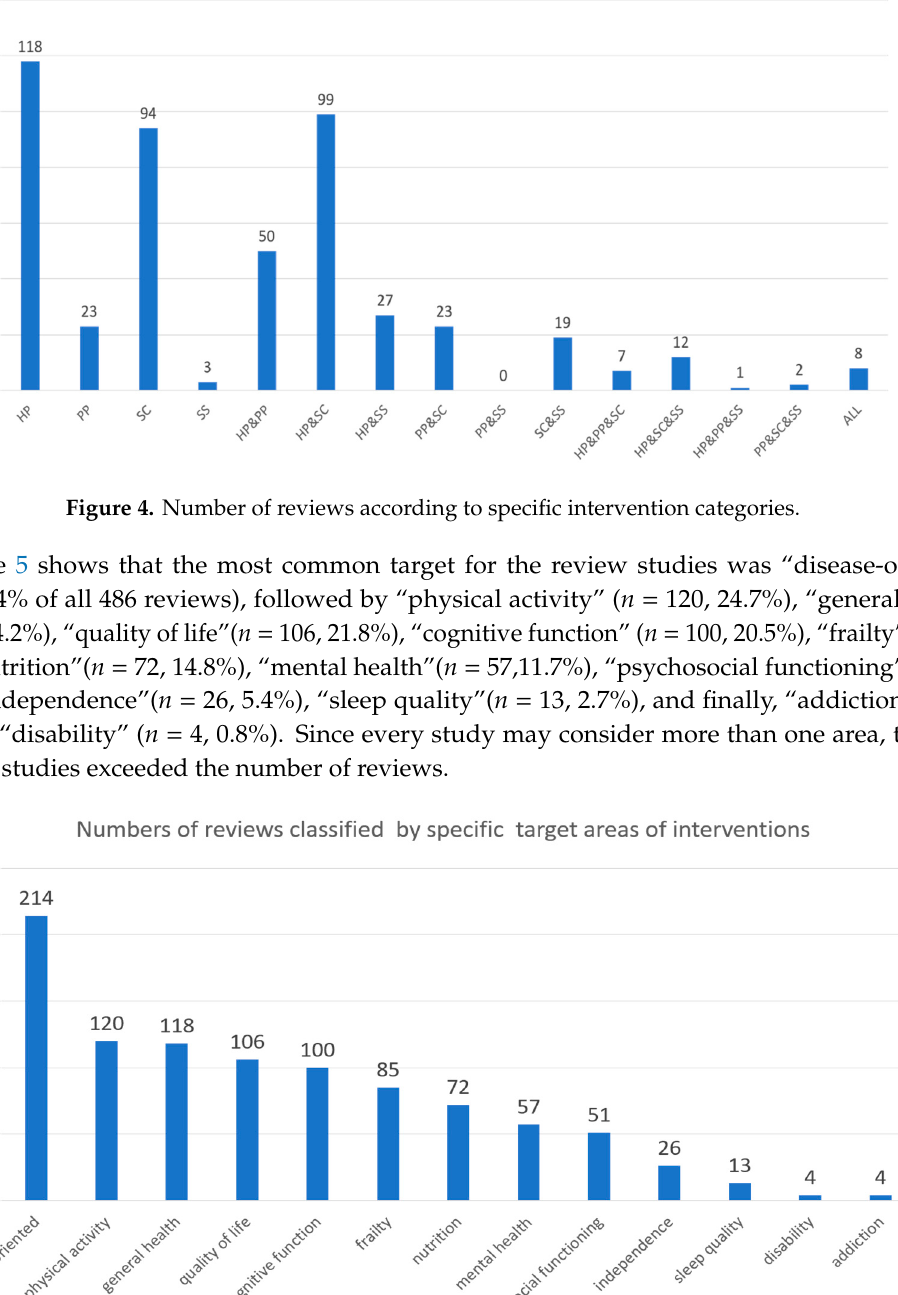
Figure 5. Number of reviews classified by specific intervention target area.